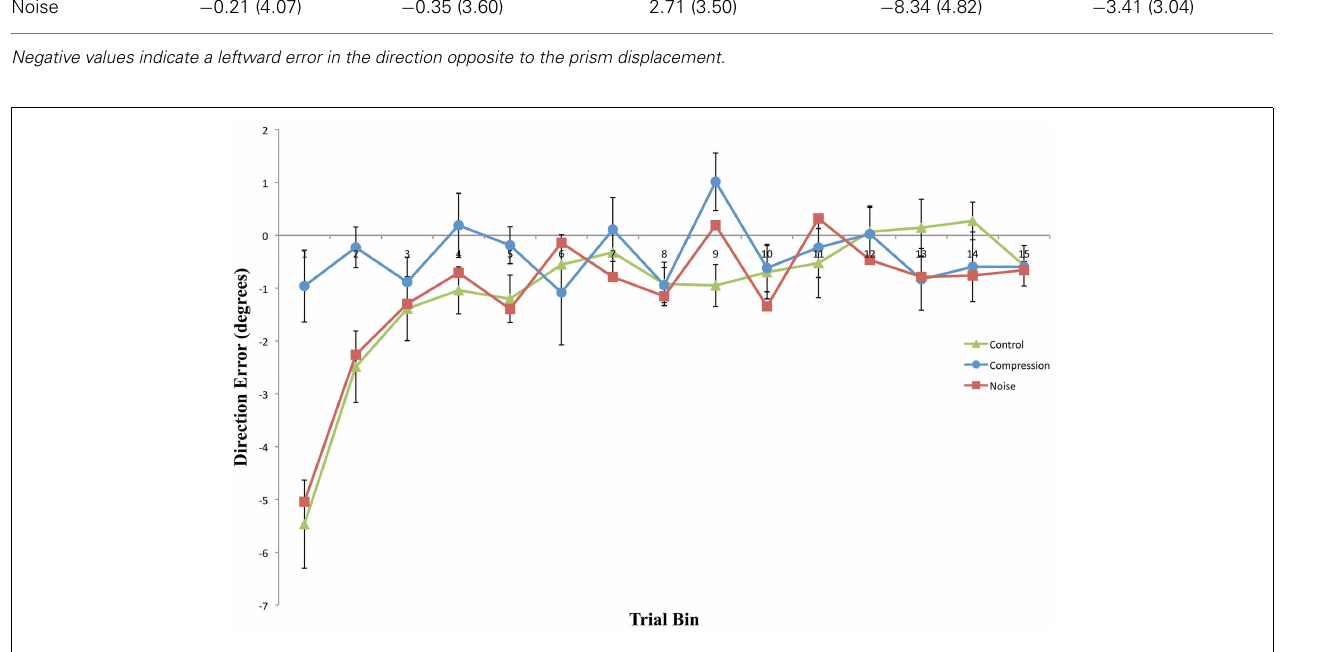
Frontiers in Human